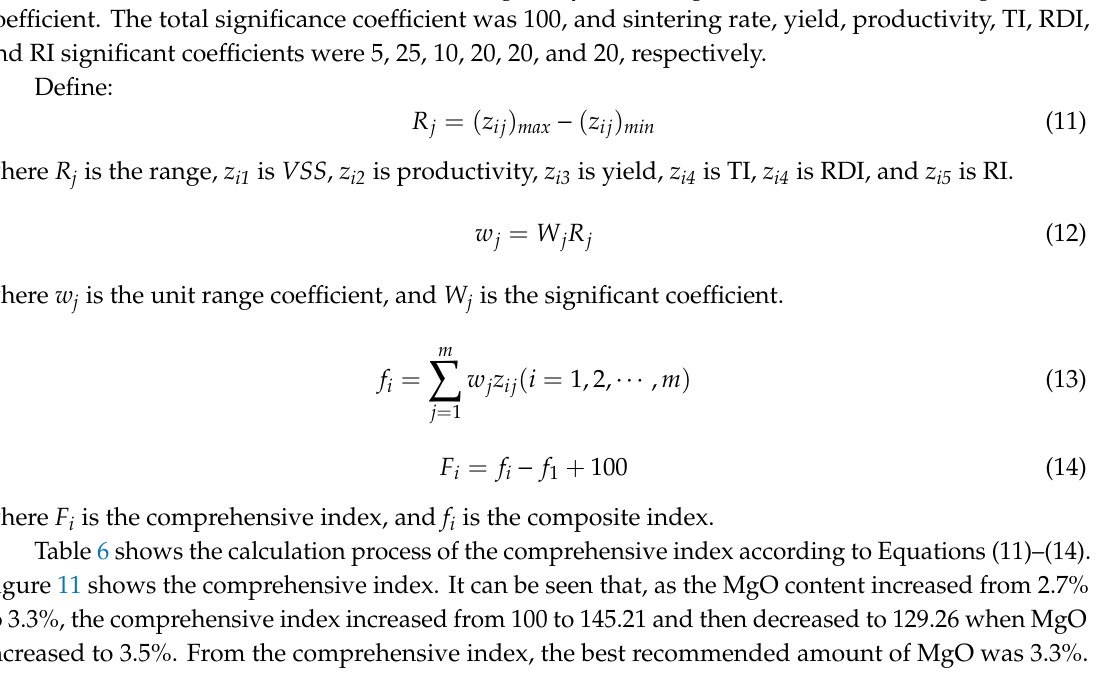
Table 6. Calculation process of comprehensive index.